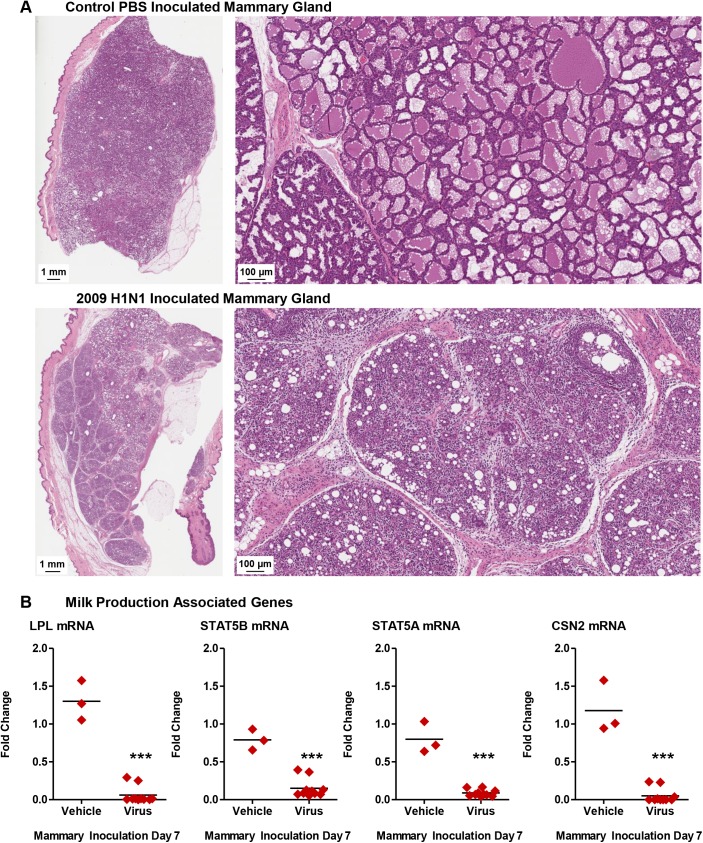
Influenza virus infection mammary glands causes milk cessation and the destruction of gland architecture.High resolution scan of Control and 2009 H1N1 inoculated mammary glands (H&E) (A). qRT-PCR profiles of milk production genes in 2009 H1N1 virus and vehicle inoculated mammary tissue (B). *** Indicates a p-value less than 0.001. Data was collected and analyzed from three independent mammary gland inoculation experiments (3 mammary inoculated mothers, 18 infants) and mock mammary inoculation controls (3 mammary mock inoculated mothers, 21 infants). Results presented show data or are representative of 3 mammary inoculations.